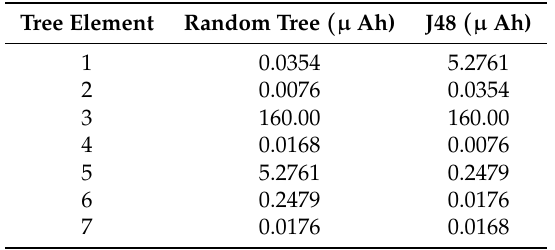
Table 6. Energy consumption estimation for each tree